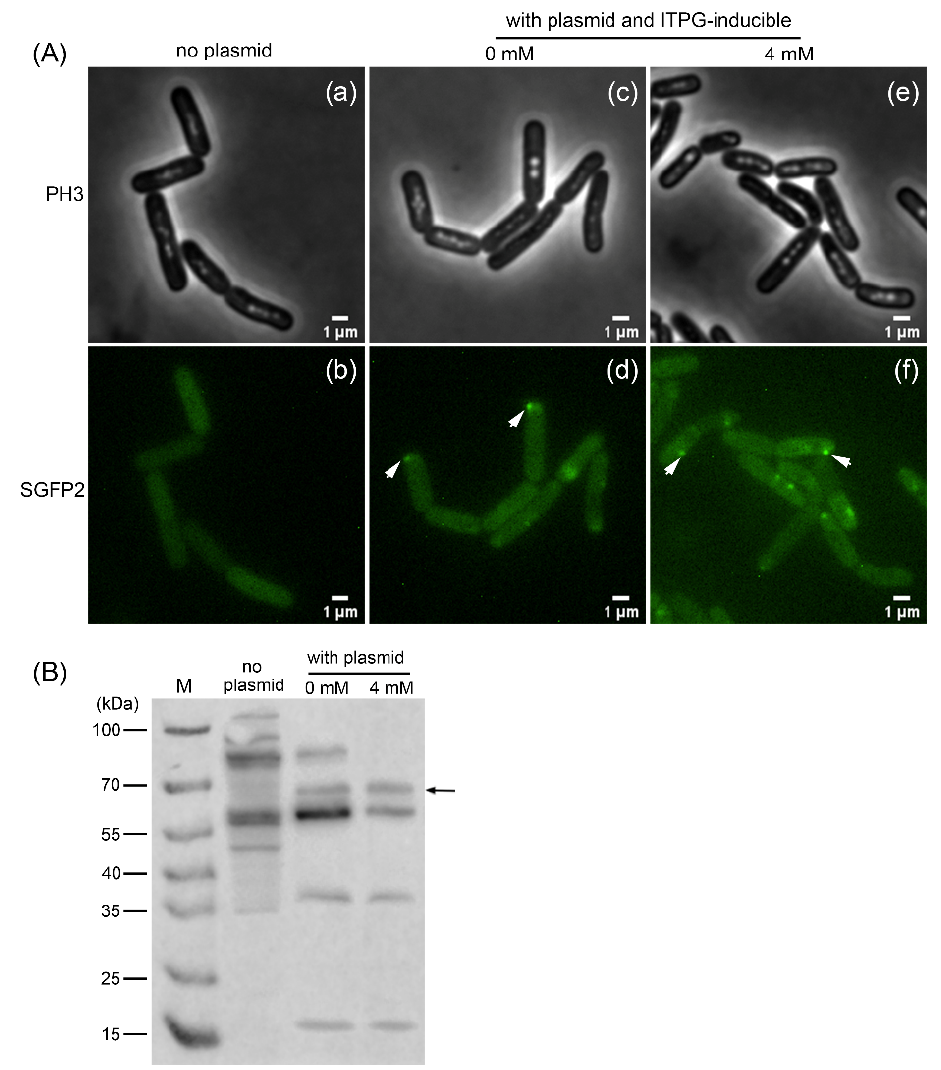
Figure 4. Visualization and detection of GerRB-SGFP2 in vegetative B. cereus cells containing plasmid pDG148- gerRB - SGFP2 . ( A ) Phase contrast (PH3) microscopy (panels Aa–Ac) and (SGFP2) fluorescence microscopy (panels Ad–Af) of B. cereus vegetative cells with or without plasmid pDG148- gerRB - SGFP2 . Panels Aa and Ab—cells without plasmid. Panels Ac and Ad—cells with plasmid but grown without IPTG (0 mM). Panels Ae and Af—cells containing plasmid grown with 4 mM IPTG. ( B ) Detection of GerRB-SGFP2 expression by Western blot analysis. Lane M, PageRuler™ Prestained Protein Ladder; no plasmid lane—protein of wild type cells; 0 mM lane—protein of cells containing plasmid and grown without IPTG; and 4 mM lane—protein of cells containing plasmid and grown with 4 mM IPTG. White arrows in A indicate foci of the GerRB-SGFP2 fusion protein. The black arrow in B denotes the expected size of the GerRB-SGFP2 protein at ~70 kDa.